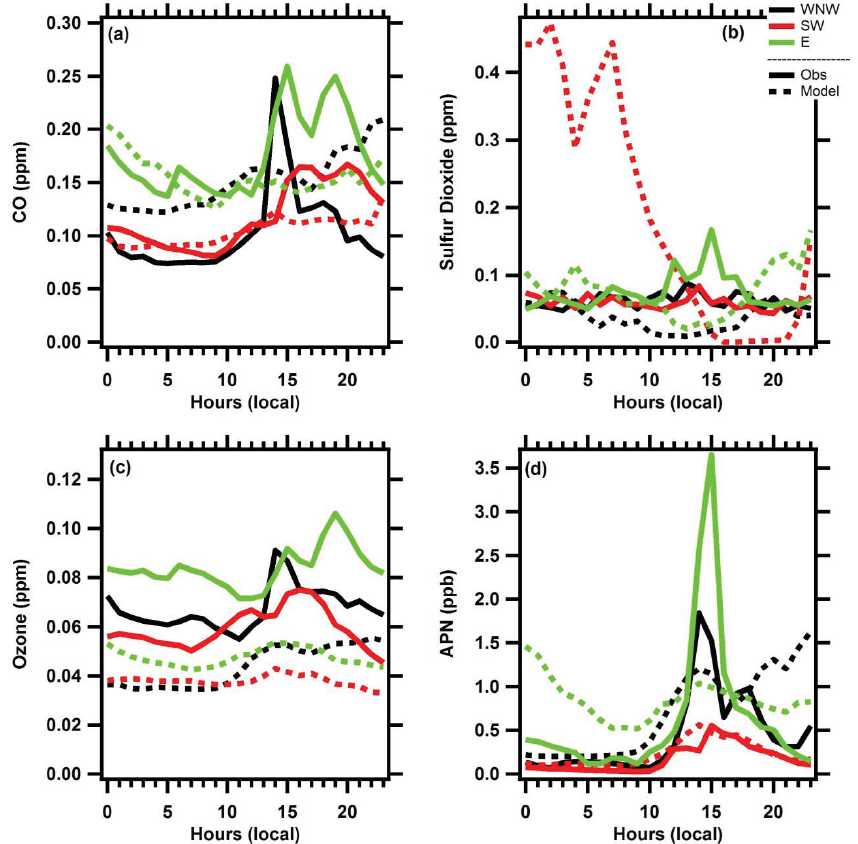
Figure 4. The average simulated (dashed lines) and observed (solid lines) mixing ratios for: (a) carbon monoxide (CO), (b) Sulfur dioxide (SO 2 ), (c) Ozone (O 3 ) and (d) acyl peroxy nitrate (APN) are shown here as a function of the air mass origin.